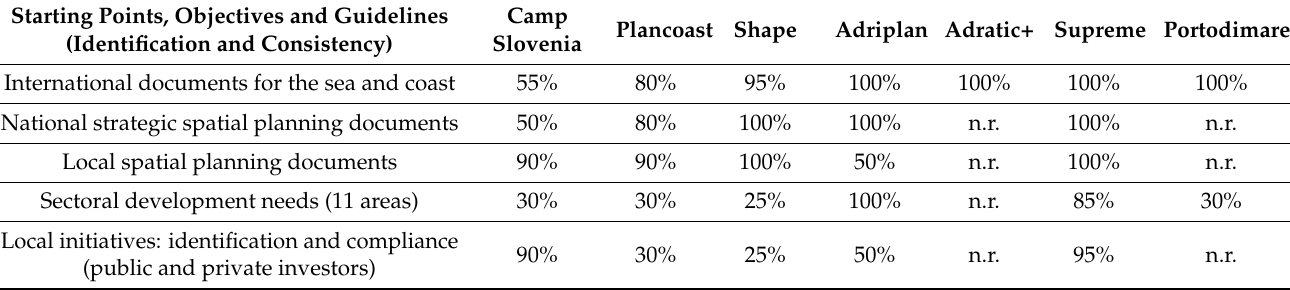
Table 4. Comparison of the draft plan and individual projects relating to their consistency with the starting points, objectives, and guidelines of relevant international and national documents and